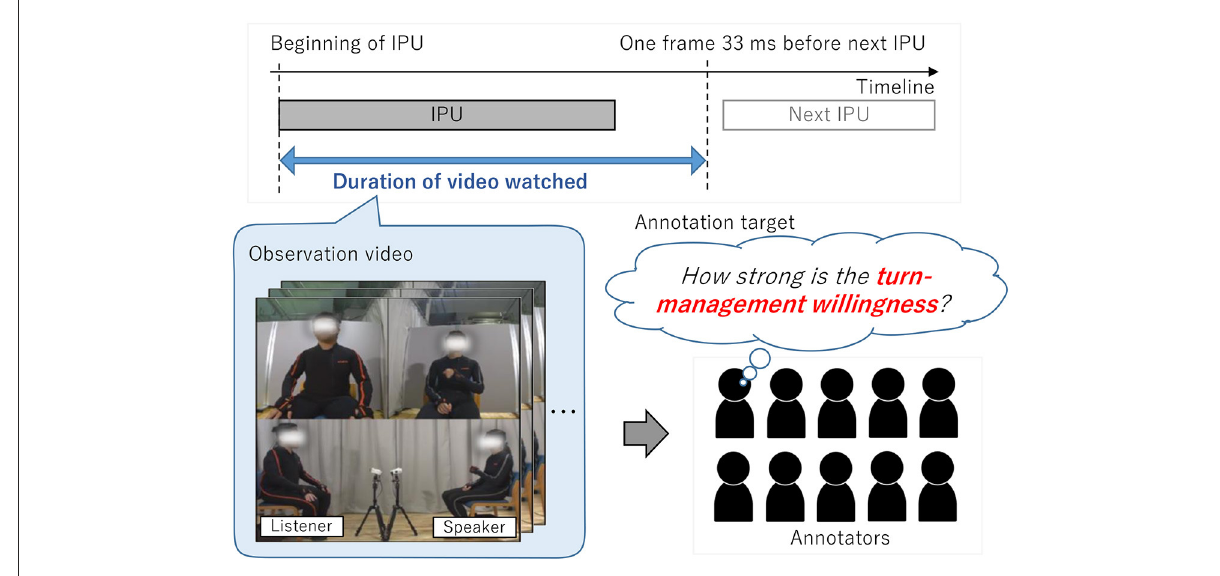
FIGURE3 Scheme for annotating speaking and listening willingness of speaker and